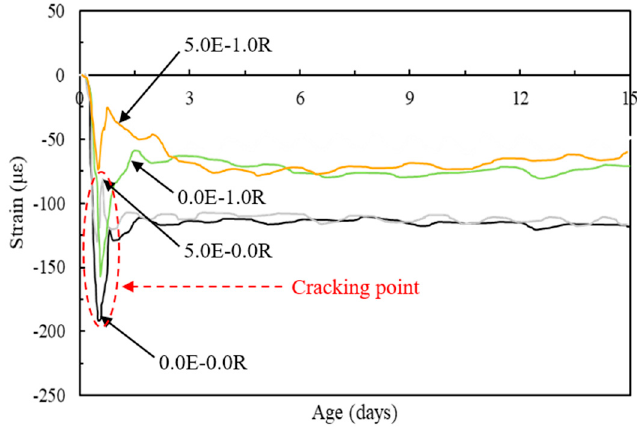
Figure 7. Strain behavior of HPC using different admixtures.